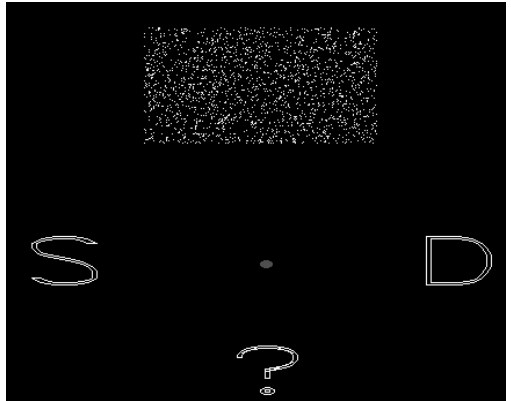
Figure 2 . Illustrating a trial in a Sparse-Uncertain-Dense